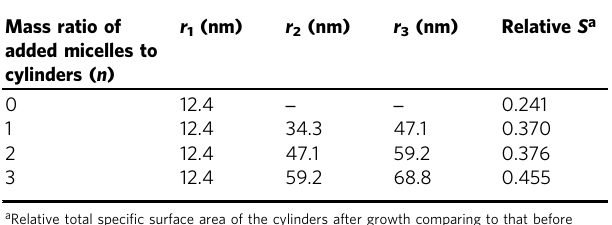
Table 1 Summary of the radiuses of the cylinders and relative speci fi c surface areas at different mass ratio of added micelles to